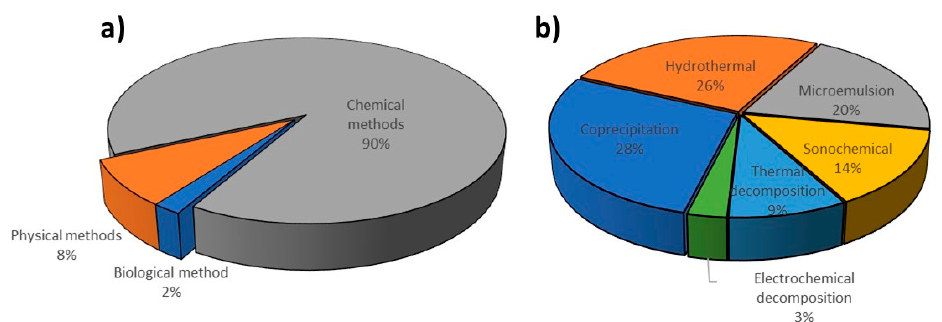
Figure 1. ( a ) A comparison of the synthesis of magnetic nanoparticles (MNPs) by three different routes; ( b ) classification of chemical methods for the synthesis of magnetic nanoparticles.